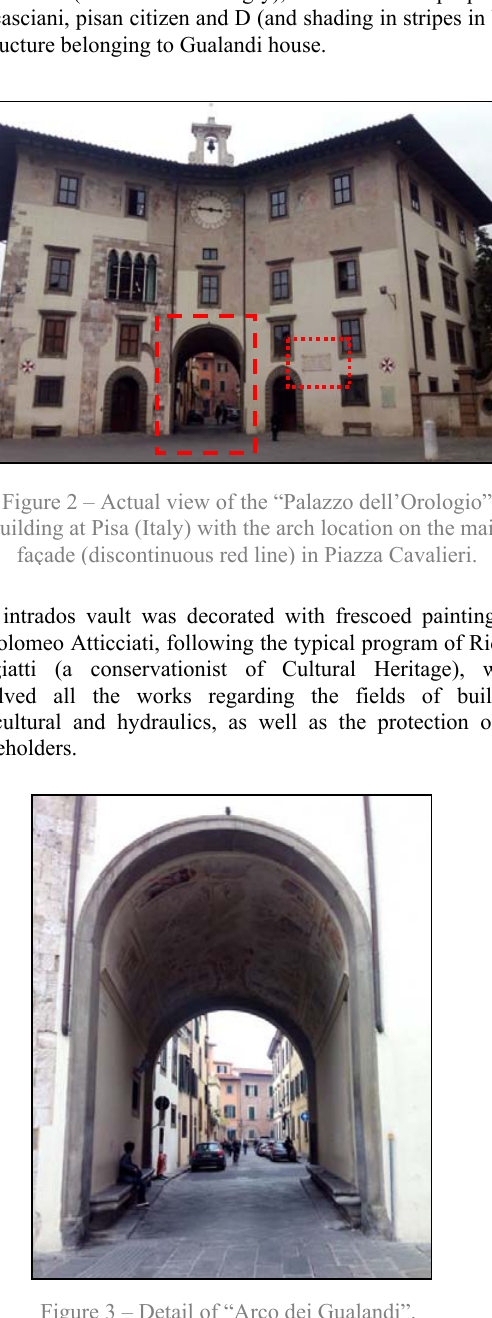
Figure 3 – Detail of “Arco dei Gualandi”.